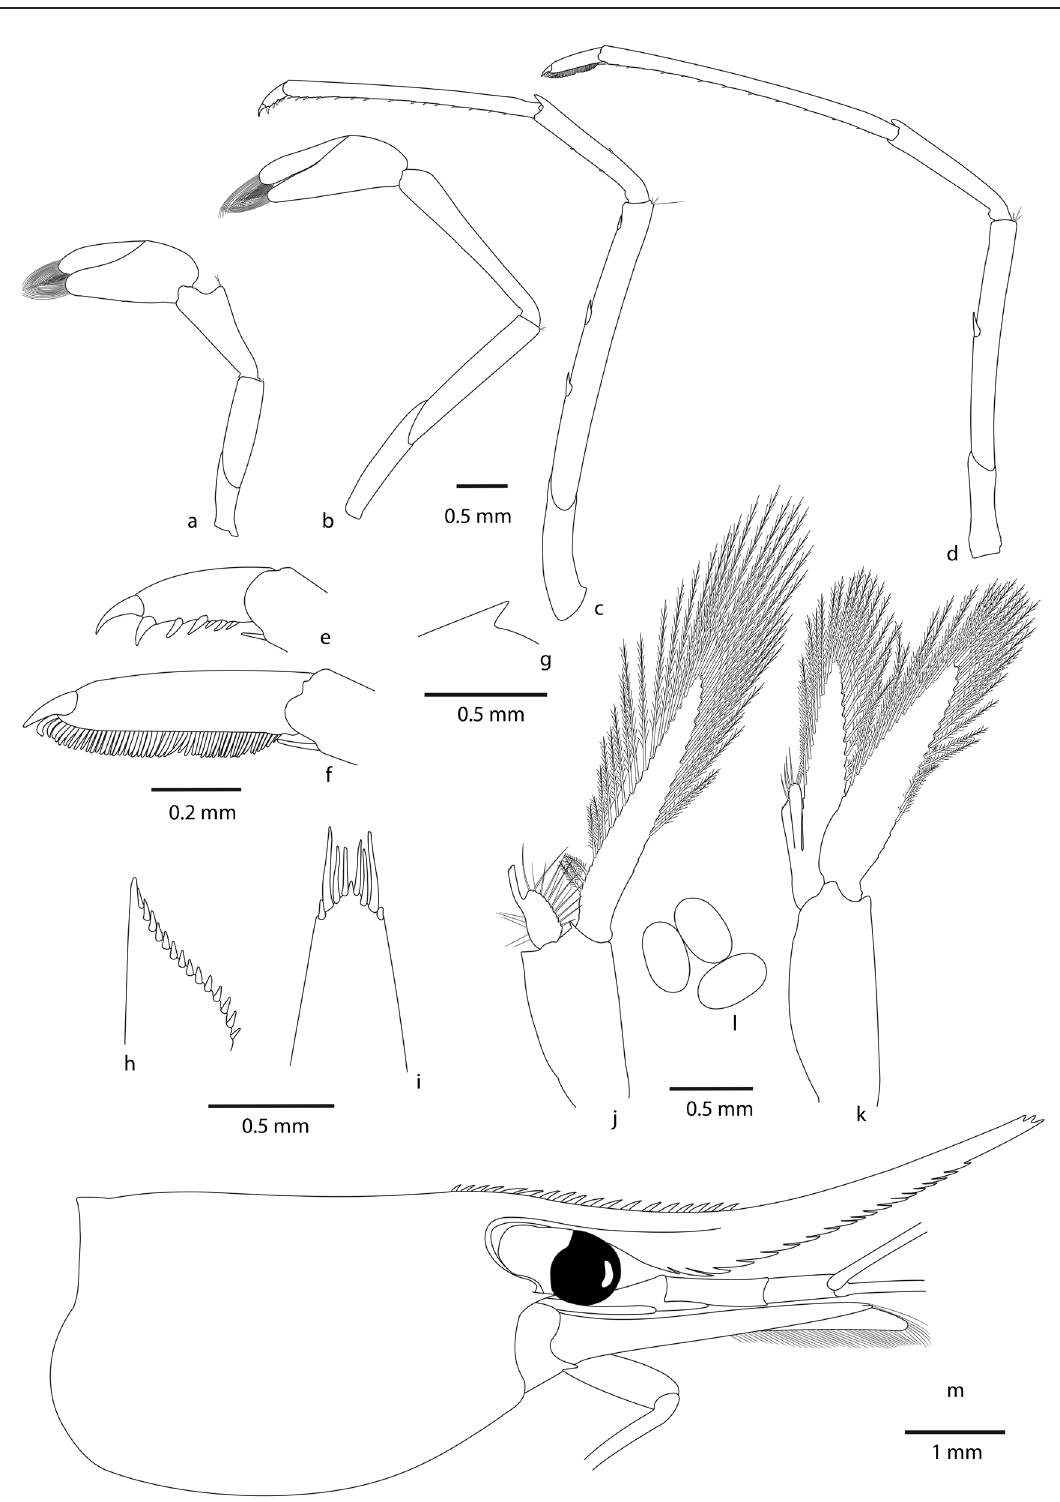
Fig. 7. Caridina intermedia sp. nov. a . First pereiopod. b . Second pereiopod. c . Third pereiopod. d . Fifth pereiopod. e . Dactylus of third pereiopod. f . Dactylus of fifth pereiopod. g . Pre-anal carina. h . Uropodal diaeresis. i . Telson. j . First male pleopod. k . Second male pleopod. l . Eggs. m . Cephalothorax. MNHN- IU-2014-20842 (a–h, l), MNHN-IU-2014-20843 (i), MNHN-IU-2014-20850 (j–k) and MNHN- IU-2014-20860